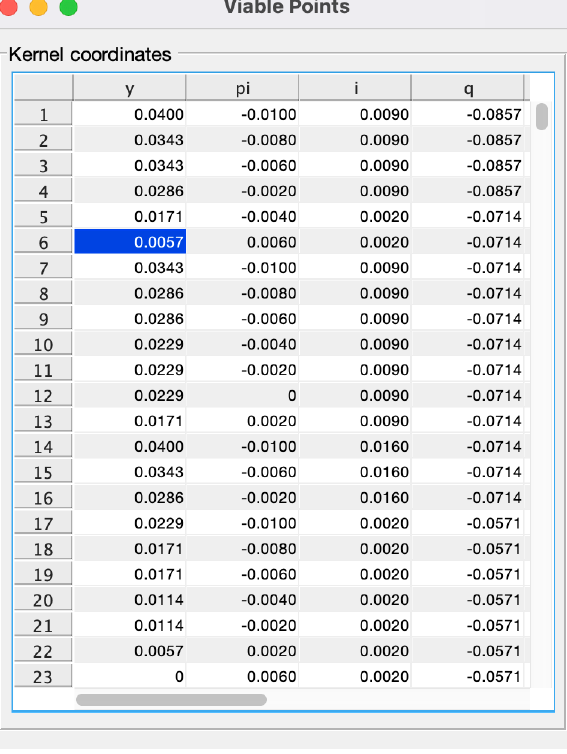
Figure 2. Viable points